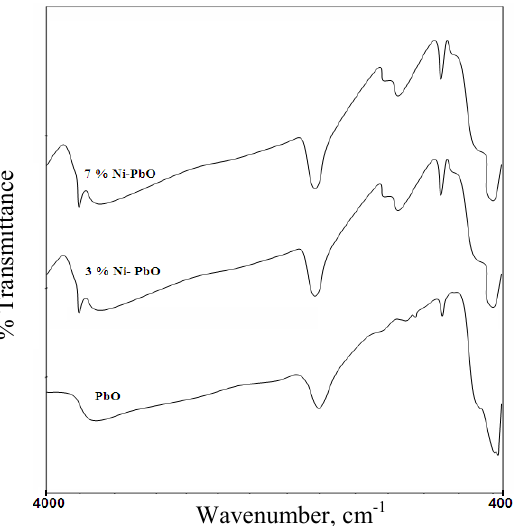
Figure 1. IR spectra of PbO and Ni doped PbO